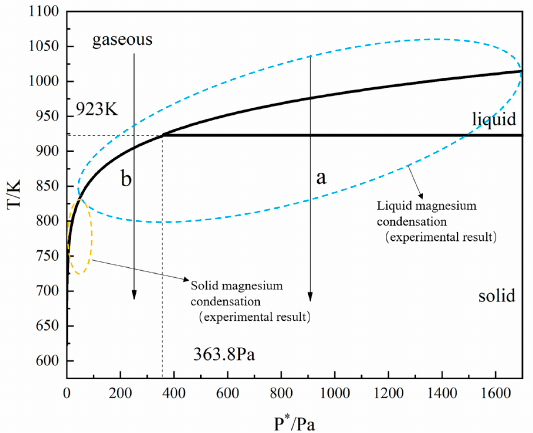
Figure 10. Three-phase diagram and experimental results Mg (1473 K heating and 0.2 m 3 /h Ar).